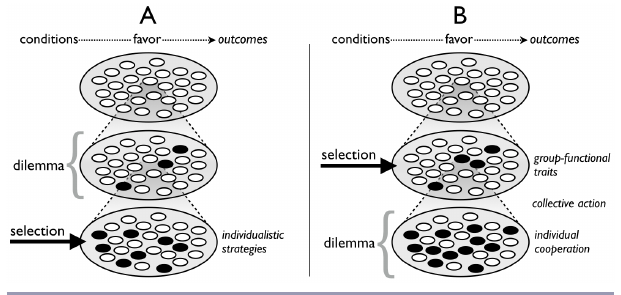
Fig. 2 . The cultural multilevel selection (CMLS) framework provides a comparative heuristic for determining cooperative outcomes in an environmental dilemma. The relationship between the dominant level of selection ( → right arrow) and the social scale of an environmental dilemma ({ right brace) determines the spread of a cooperative environmental trait (open circle). (A) When the dominant level of selection is below that of the dilemma, selection on individuals favors individualistic strategies, noncooperation (filled circle), resulting in an unresolved dilemma. (B) When the dominant level of selection is above that of the dilemma, selection on groups favors group-functional traits, collective action, individual cooperation (open circle) and a resolution to the